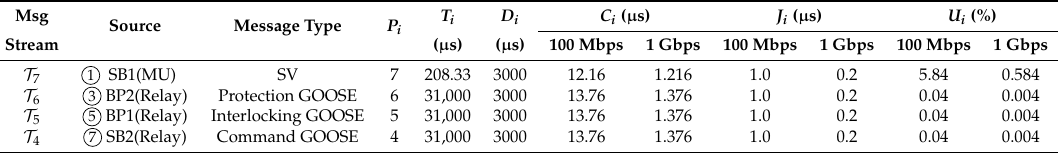
Table 4. T1-1 system message stream parameters for 100 Mbps and 1 Gbps